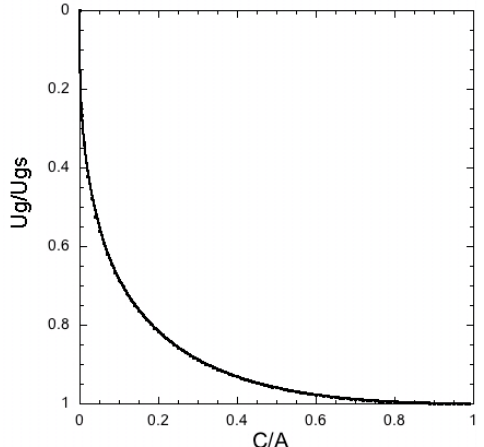
Figure 7. Ratio of the gravitational potential energy of a homogeneous, oblate object ( U g ) with aspect ratio C/A to that of a homogeneous sphere ( U gs ) with the same density, mass and volume, calculated with Equation (17). Because U gs is negative, energy is lost as objects become progressively “rounder”, and for this reason the vertical axis is reversed.